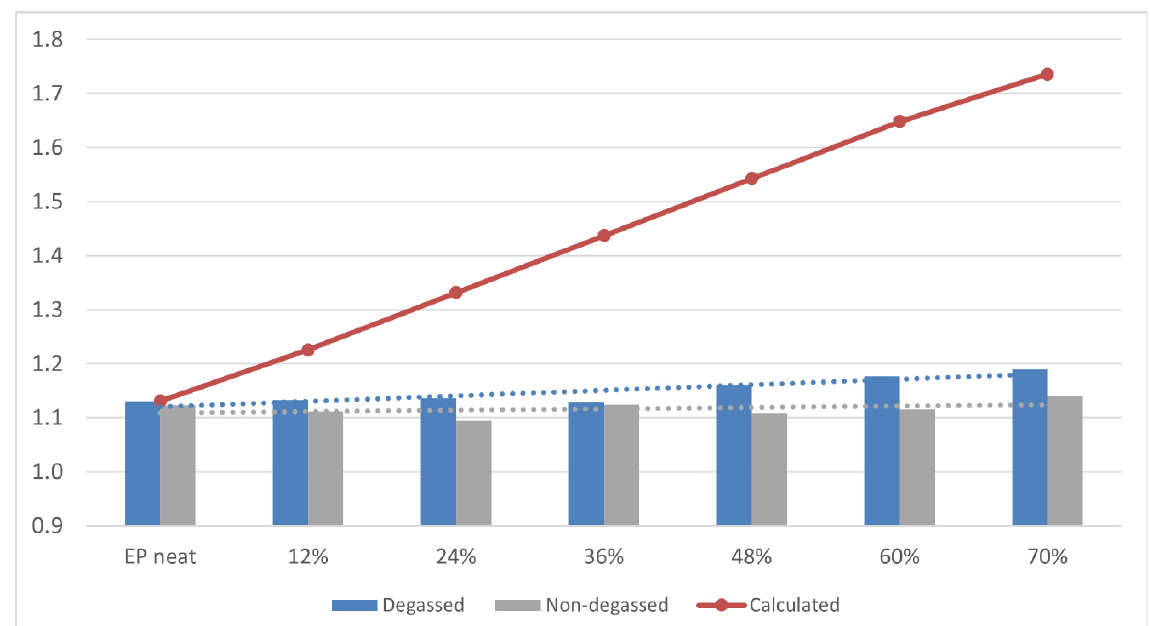
Figure 9. Density of degassed and non-degassed epoxy resin containing base diatomite earth.